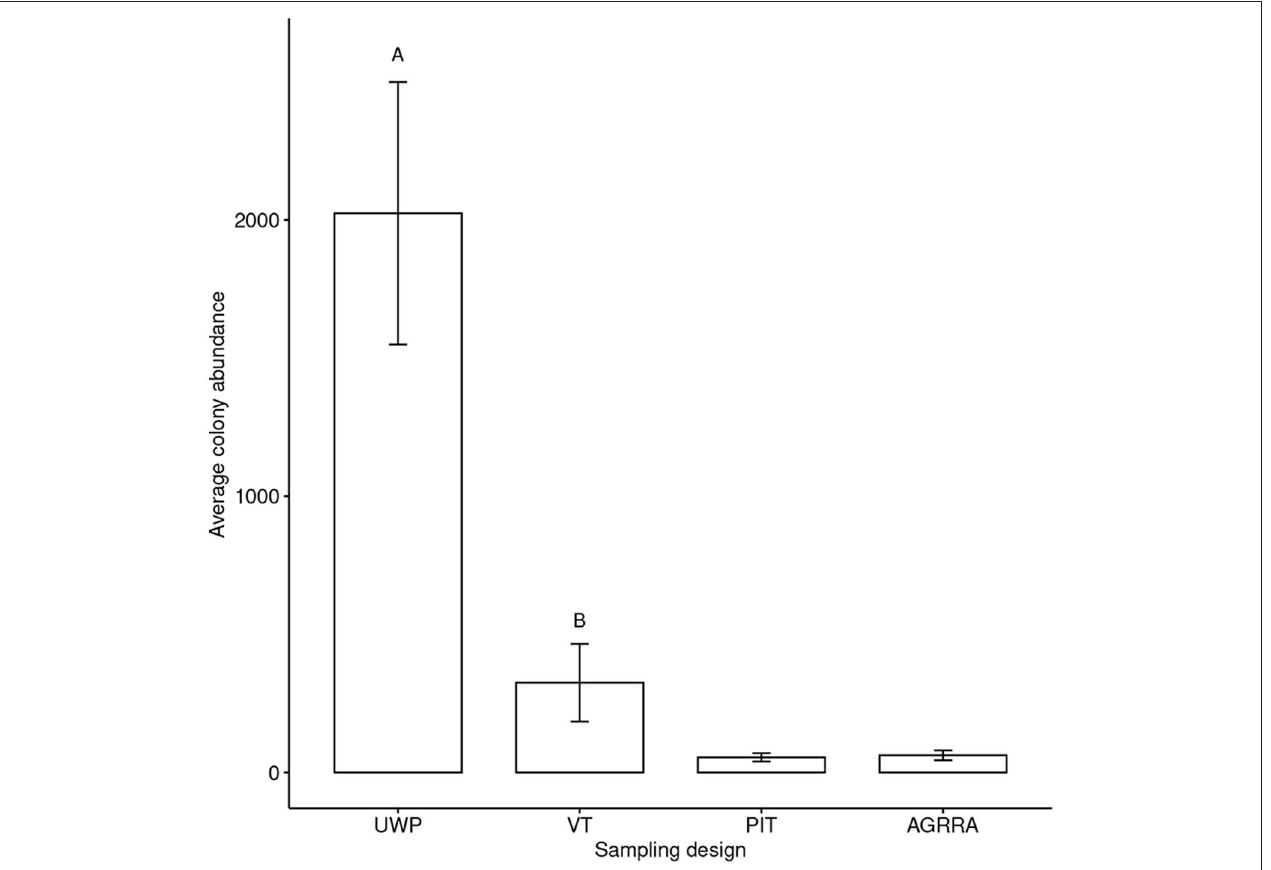
FIGURE 5 | Average colony abundance ( ± SD) obtained with each sampling design. Underwater digital photogrammetry (UWP), videotransect (VT), point intercept transect (PIT), and Atlantic and Gulf Rapid Reef Assessment (AGRRA). Letters indicate the sampling designs where the average colony abundance had a significant difference ( p <